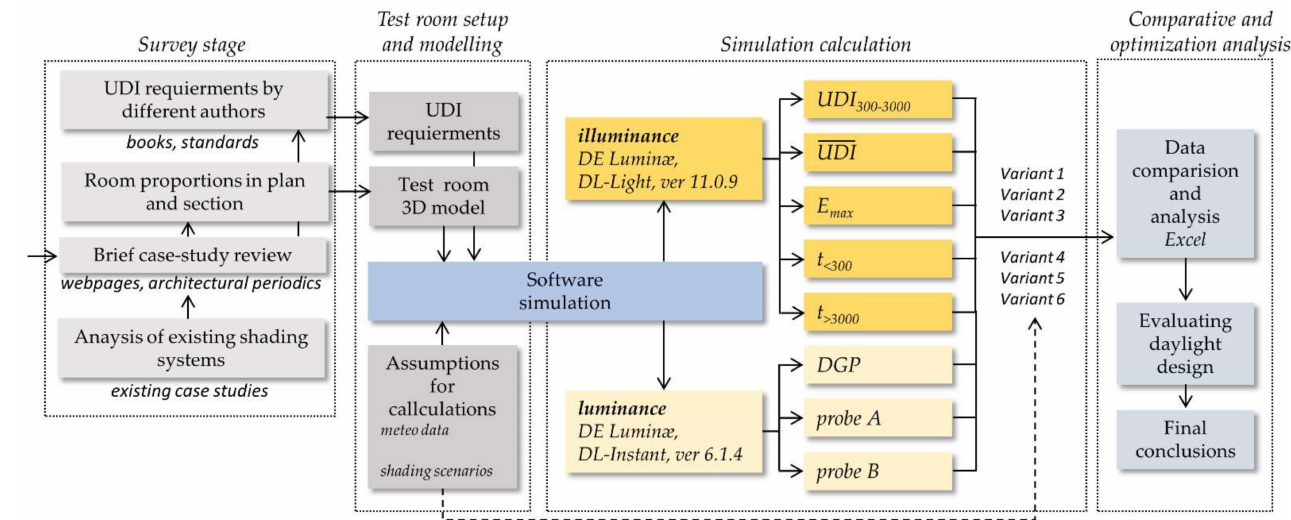
Figure 4. The schematic diagram of the adopted methodology and sequence of simulation.